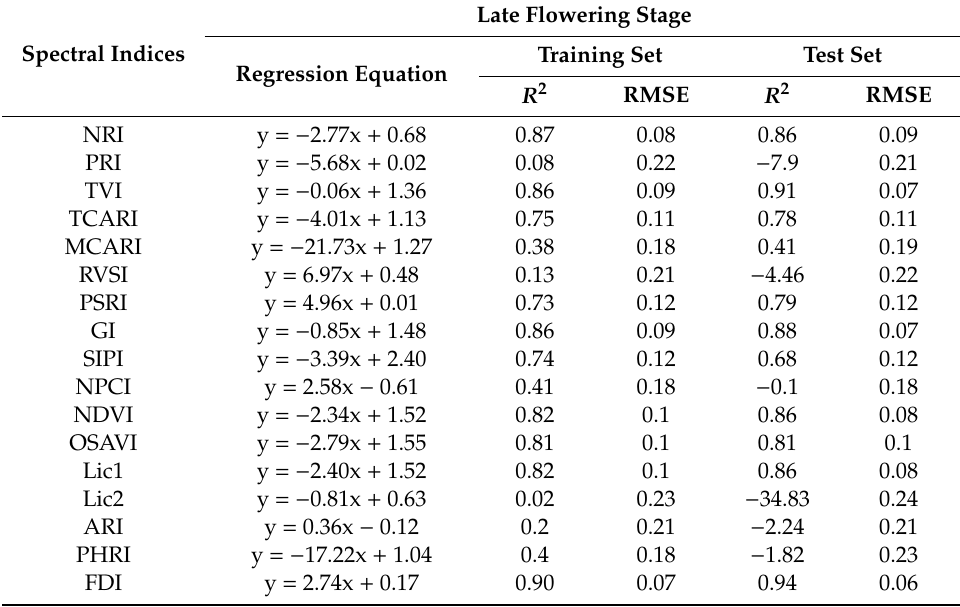
Table 2. Comparison of proposed FDI and traditional spectral indices at the late flowering stage.